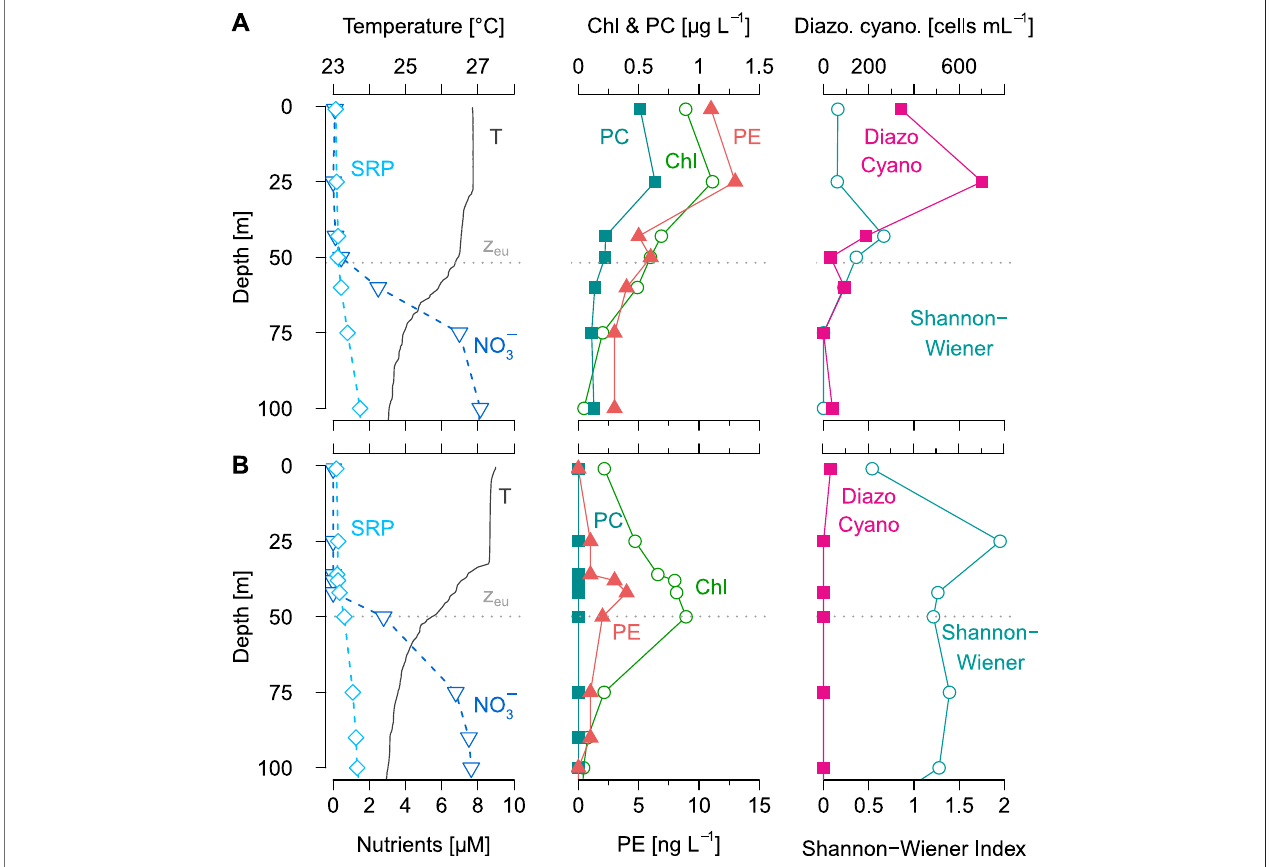
FIGURE 3 | Vertical pro fi les of physicochemical, pigment and phytoplankton data from two exemplary stations at the end of the rainy season (April/May 2018). Station 4 (A) represents a thermocline below the euphotic zone, whereas station 8 (B) exempli fi es a thermocline within the euphotic zone. The left panels shows temperature (T), euphotic depth (z eu ), nitrate (NO 3 − ), phosphate (SRP), the middle panels depict chlorophyll- a (Chl), phycocyanin (PC), and phycoerythrin, whereas the right panels represent the abundances of diazotrophic cyanobacteria and the Shannon-Wiener diversity index of the phytoplankton community ( > 10